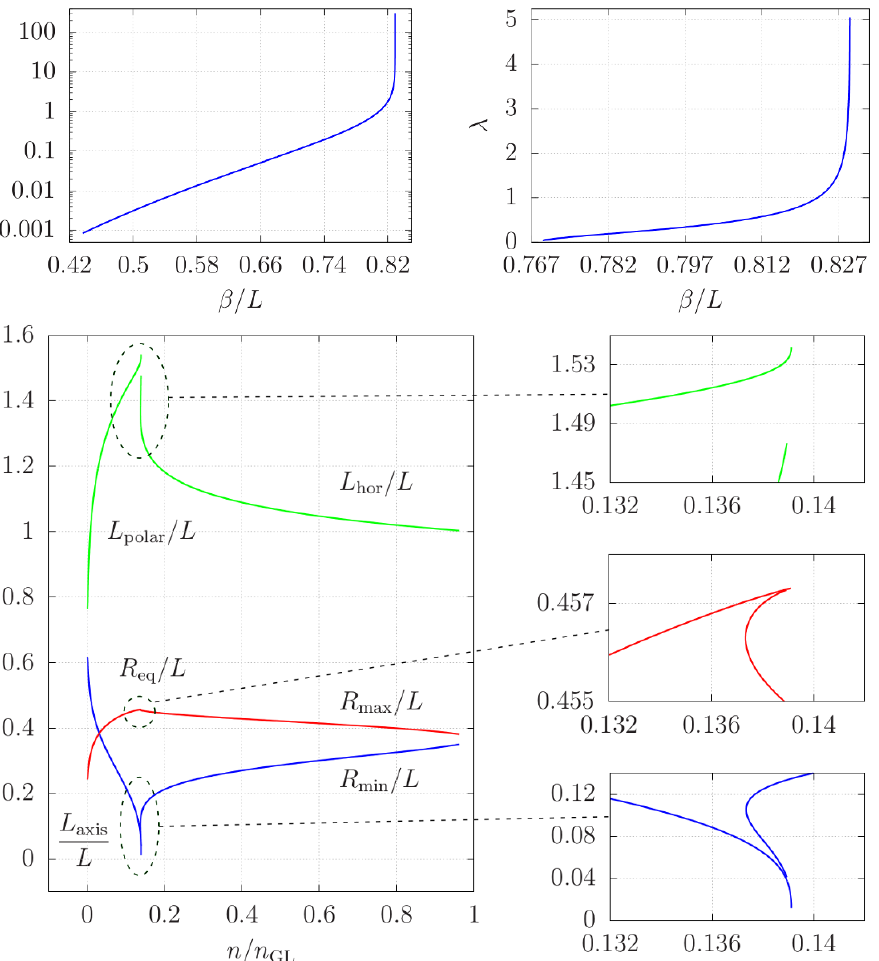
Figure 5 . Eccentricity (top left) and non-uniformity parameter (top right) as a function of the dimensionless inverse temperature. These quantities give a direct measure of the deformation of LOC and NUBS respectively. Di(cid:11)erent geometrical lengths and radii for NUBS and LOC (bottom) as a function of the relative tension normalized at the GL threshold